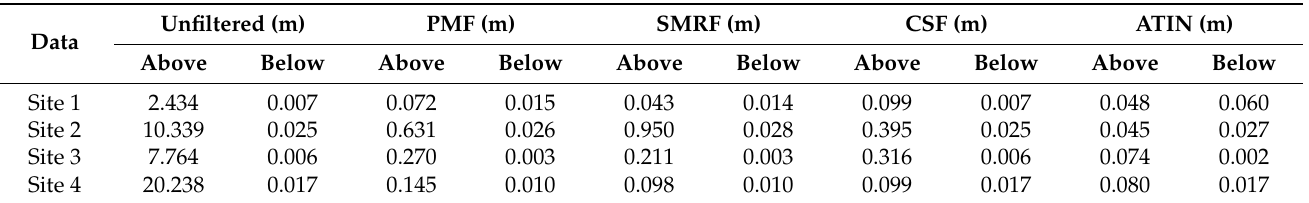
Table 4. RMSDs of unfiltered point cloud and data from individual sites ground-filtered using various filters compared with MDSR-based